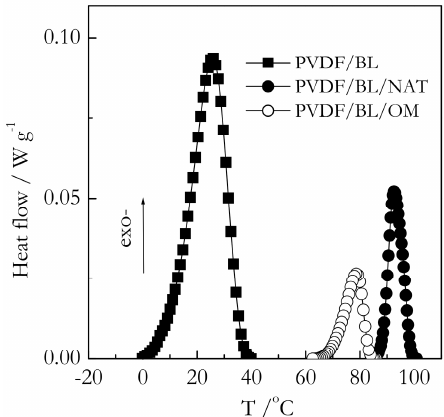
Figure 4. DSC curves for BL-based gels at a cooling rate of 8 ◦ C min − 1 . The bulk gel is represented by squares, PVDF/BL/NAT and PVDF/BL/OM gels confined in 9 nm pores represented by solid and open circles, respectively. The heat flow values are given per gram of gel.